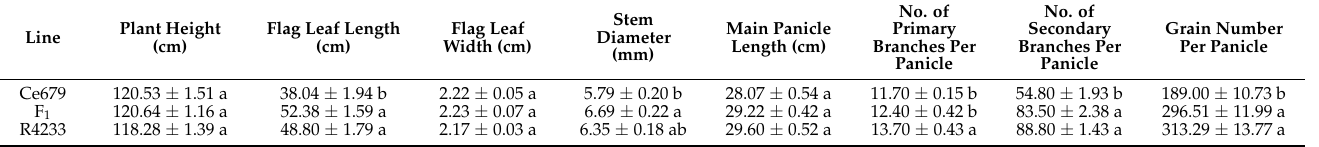
Table 2. Quantitative evaluation of the structure of the panicle in Ce679, R4233, and